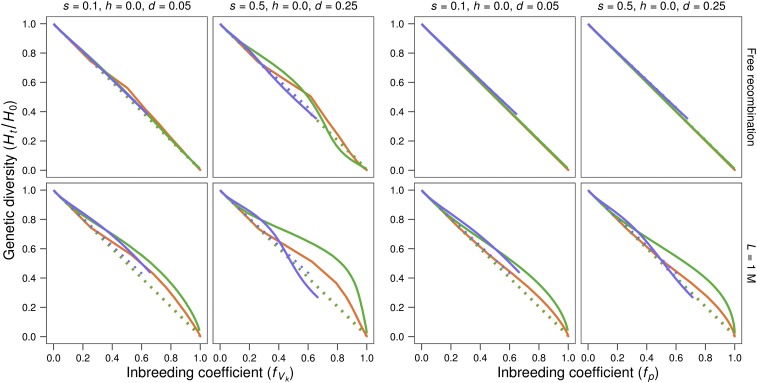
Relative neutral genetic diversity plotted against fVk or fp. Per-generation average of relative neutral genetic diversity in the lines (Ht/H0) plotted against the corresponding inbreeding expected taking into account the observed variance of gametic contributions (fVk) or the inbreeding computed using pedigree information (fp), (four left or four right panels, respectively). The different panels correspond to different deleterious effects (s) with completely recessive gene action (h = 0), assuming free recombination or a genome length of L = 1 Morgan. Red: N = 2; green: N = 10; blue: N = 50. Solid lines: lines maintained under the MSD scenario. Dotted lines: lines maintained under the MD scenario.